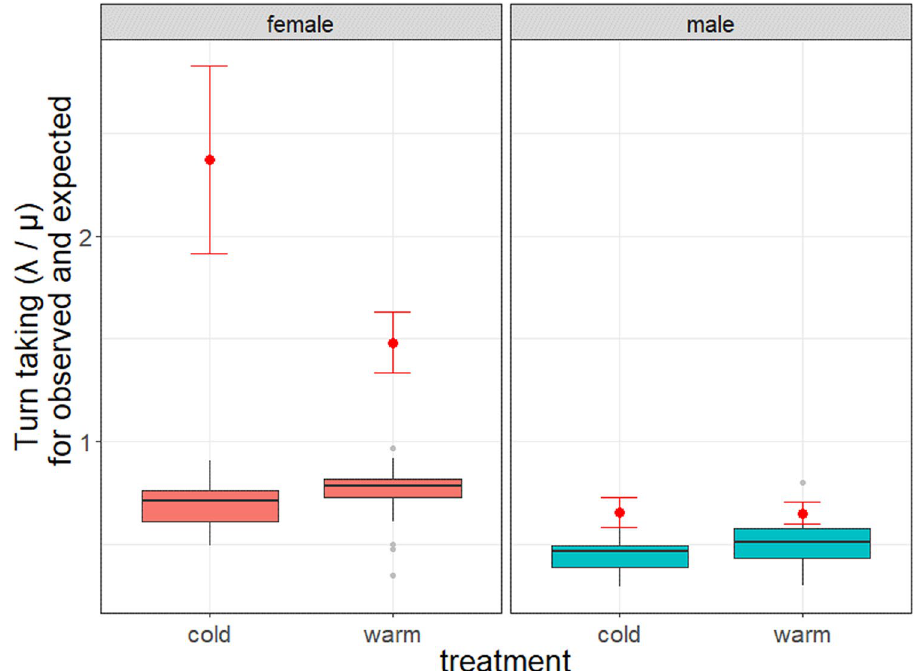
Figure 3. The turn taking levels when nestlings are 4 days old, separated for treatment and sex. Mean ± SE are represented for the observed turn taking values (red points) both females and males for the cold and warm treatment. Boxplot distributions of the expected/random turn taking levels is presented for the sexes and treatment (based on 1000 randomisations of the visit sequence). Turn taking as λ/μ; turn taking > 1 indicates that the individual follows its partner more than itself. Observed turn taking (λ/μ) mean ± SE cold treatment females: 2.4 ± 0.45; warm treatment females: 1.5 ± 0.15; cold treatment males: 0.65 ± 0.07; warm treatment